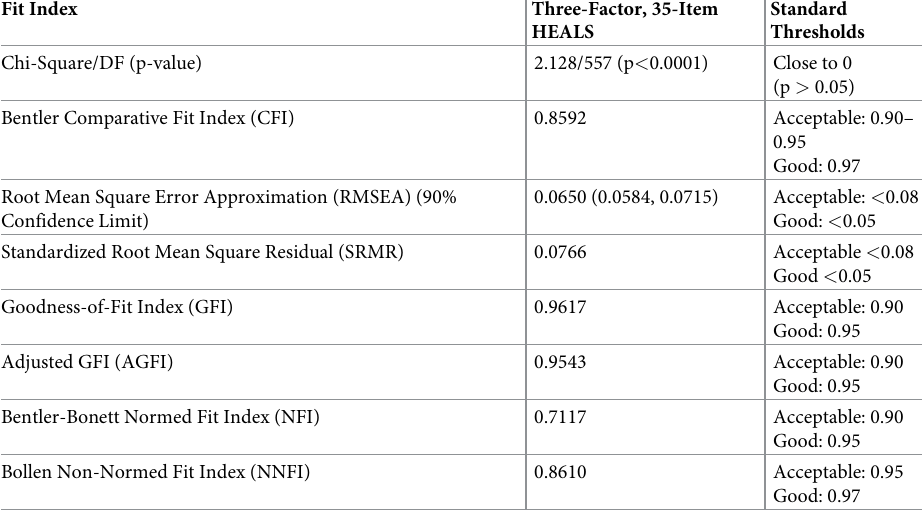
Table 4. Goodness-of-Fit indices for the three-factor, 35-item NIH healing experience of All Life Stressors (HEALS) measure. Fit